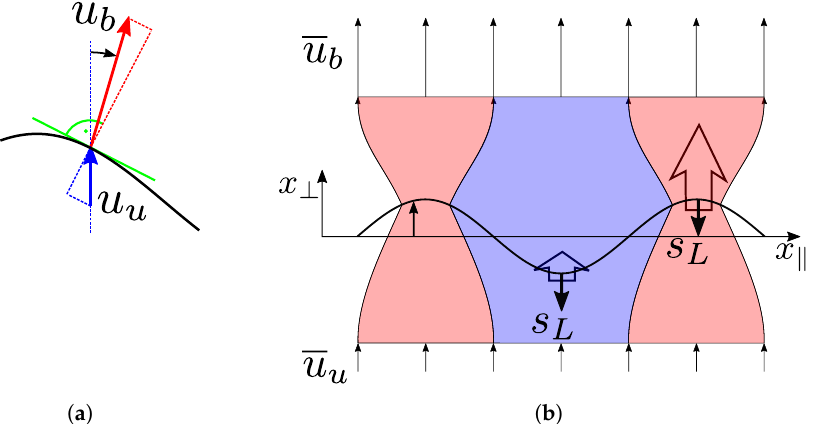
Figure 12. ( a ): Downstream of a flame, velocity vectors are bent towards the flame normal direction, since the flow accelerates across the flame front. ( b ): The instability of a flat flame sheet results from contraction (red) and expansion (blue) of flow tubes across a corrugated flame front that can be linked to consequences of flame generated vorticity (captured by the BD model) and irrotational contributions of flow expansion (not